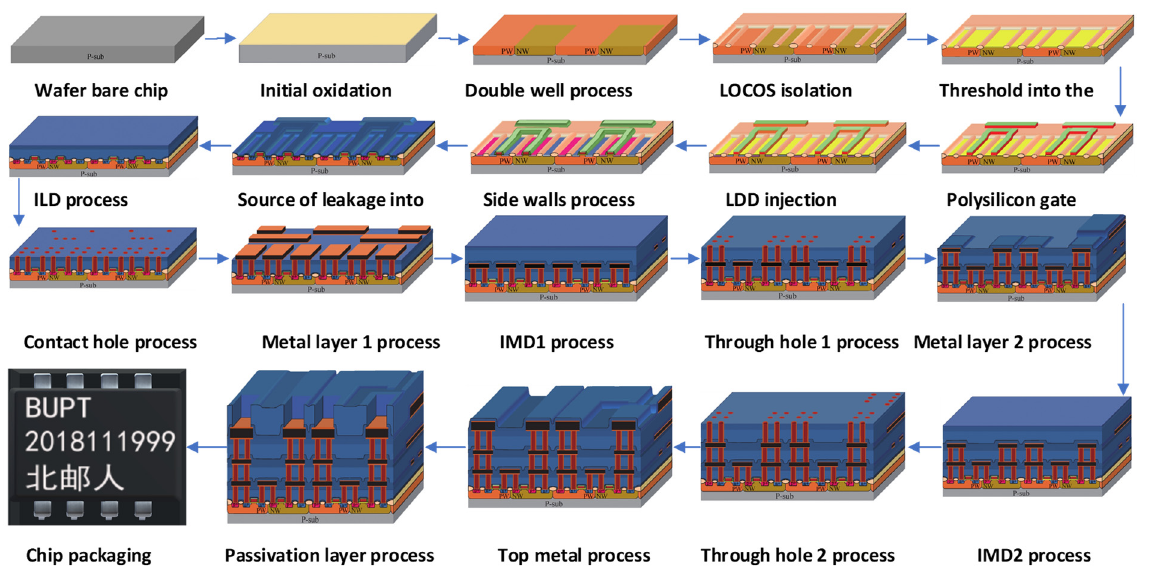
Figure 12. Step control flow chart.